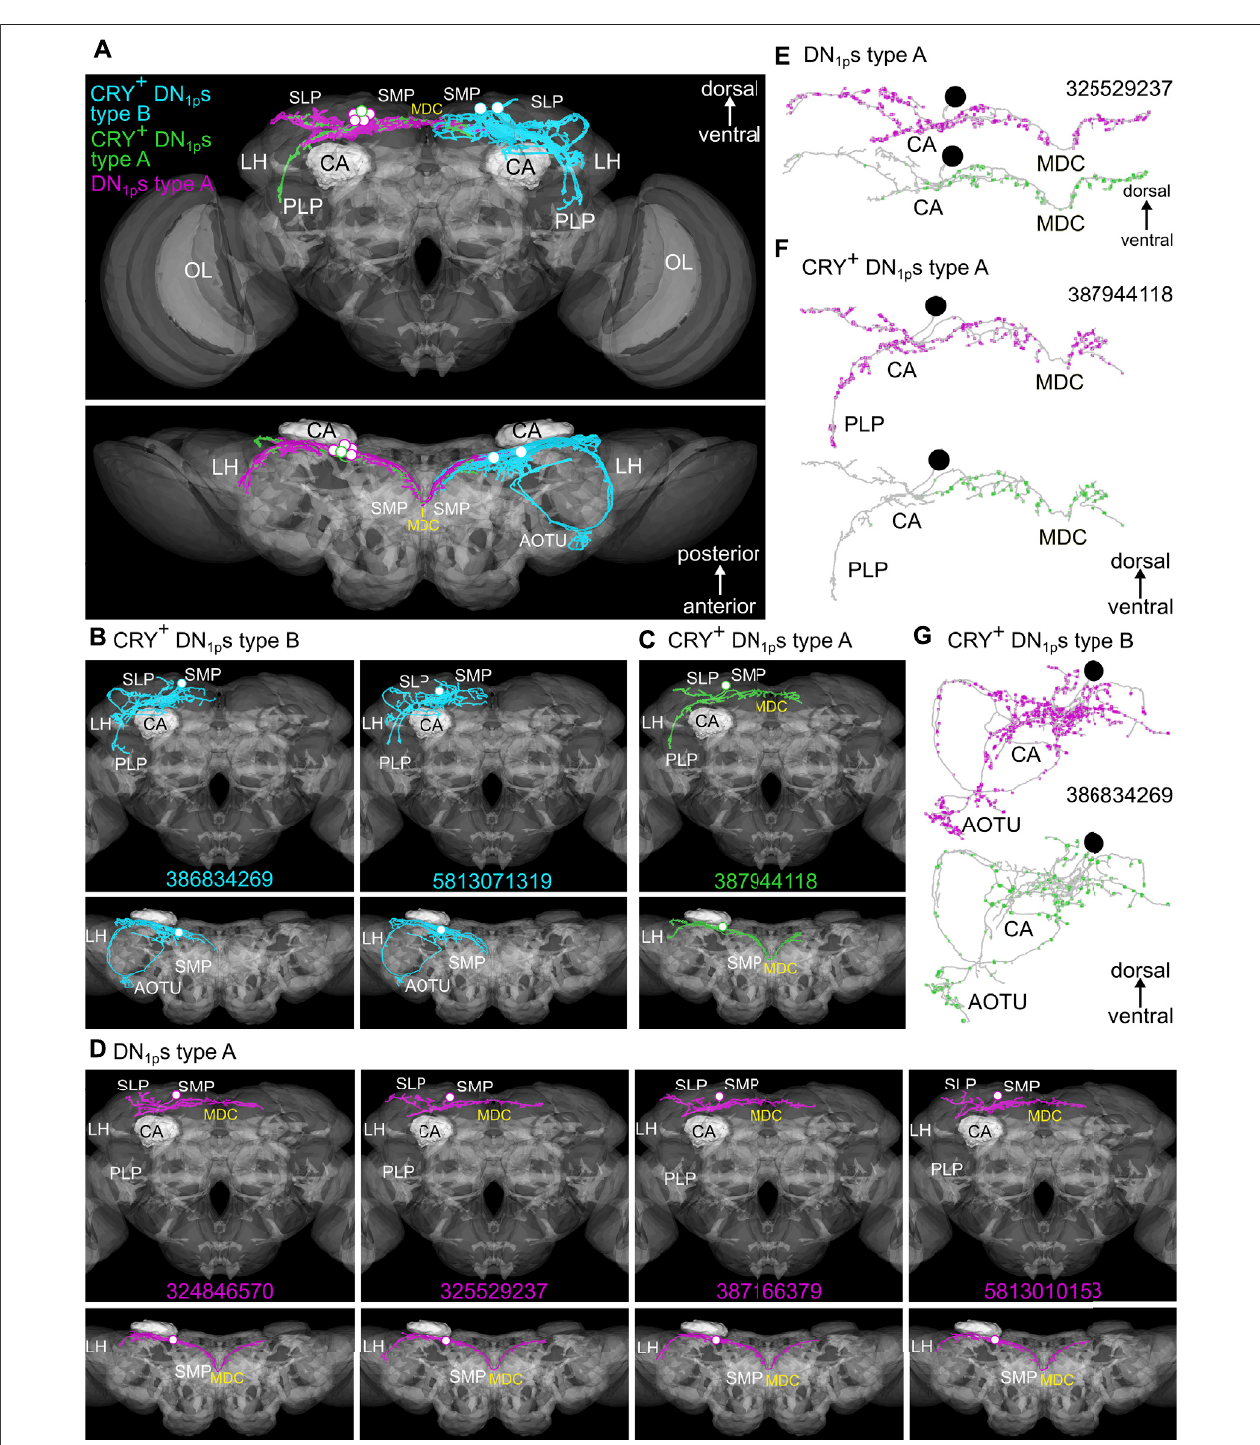
FIGURE 6 | The different morphologies of the seven DN 1p s annotated in the hemibrain. (A) Standard brain (JRC 2018F) showing the three different morphological subtypesamongthesevenDN 1p sannotatedinthehemibrain.Thepresumably CRY-positive neuronsaredepictedincyanandgreen,whilethestillunde fi ned DN 1p sare shown in magenta. (B) Detailed representation of the two Type B CRY-positive DN 1p s in ventral-dorsal (top) and anterior-posterior (bottom) orientation. Both neurons arborize in the superior lateral protocerebrum (SLP), the superior medial protocerebrum (SMP), and project ventrally to the posterior lateral protocerebrum (PLP). Additionally, they send two fi bers to the anterior optic tubercle (AOTU) each of them forming a loop that runs on the dorsal and ventral surface of the SLP, respectively (compare with G ). (C) Representation of the type A CRY-positive DN 1p (#387944118). The projections of this neuron remain mostly posterior. In the SLP, this DN 1p also